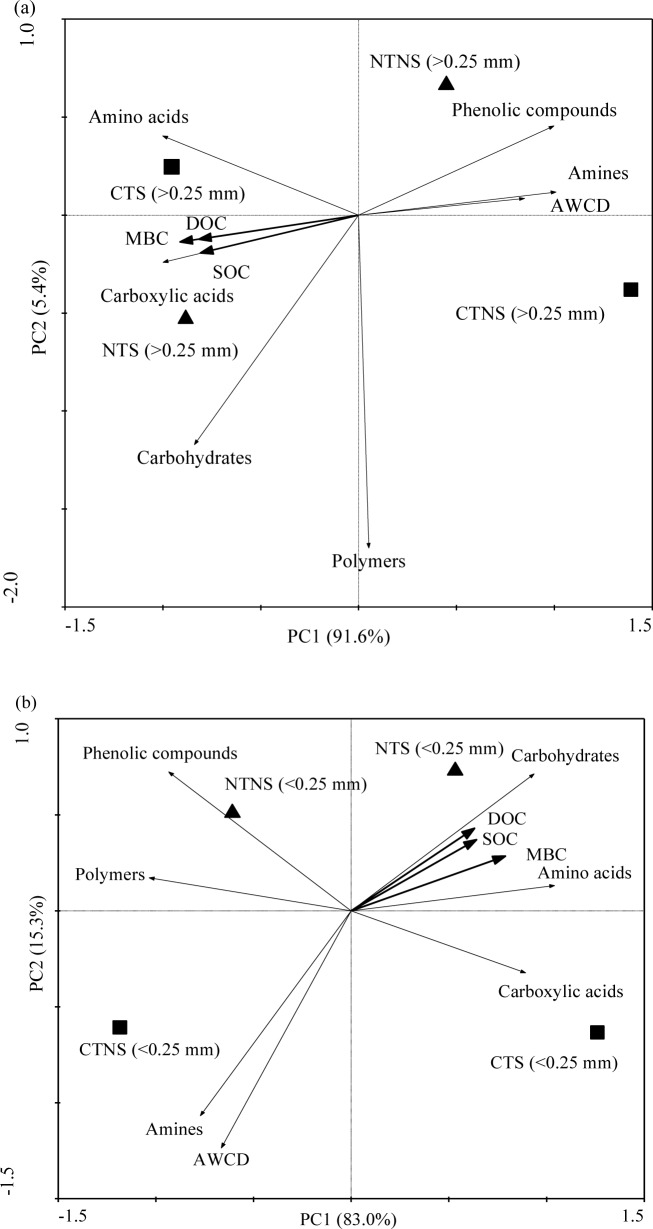
Redundancy analysis of soil microbial metabolic activities and SOC fractions in >0.25 mm (a) and <0.053 mm (b) aggregates under different tillage and residue treatments.CTNS, conventional intensive tillage with straw removal; CTS, conventional intensive tillage with straw returning; NTNS, no-tillage with straw removal; tillage; NTS, no-tillage with straw returning. SOC, soil organic C; MBC, microbial biomass C; DOC, dissolved organic C; AWCD, an average well color development.